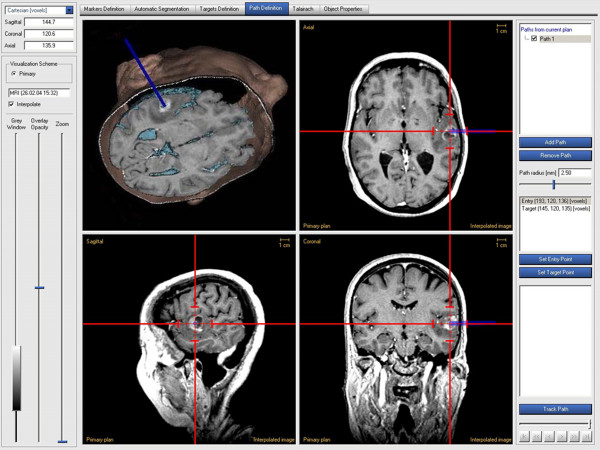
Image guidance was based on axial planar views (sagittal, coronal and transaxial), free planar views, and 3D views of the anatomical objects with tools for targeting and trajectory planning.